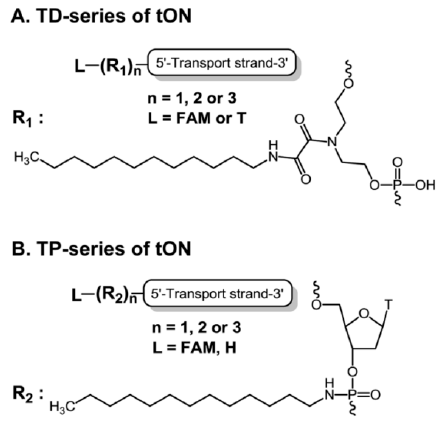
Figure 1. Structures of transport oligonucleotides of ( A ) TD- and ( B ) TP-series.